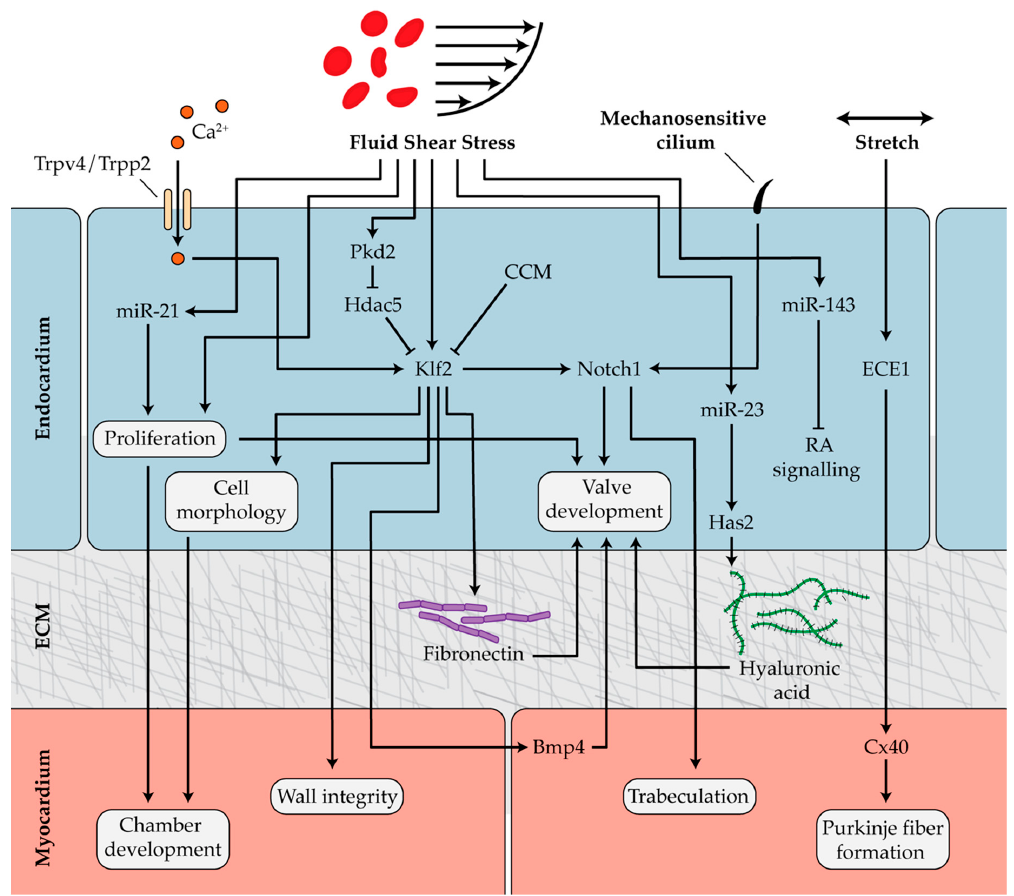
Figure 3. Mechanosensitive pathways involved in heart development. During chamber morphogenesis, hemodynamic forces control endocardial cell proliferation and, through Klf2a, direct endocardial cell morphology. Blood flow also has an impact on myocardial wall integrity, an effect that is mediated by klf2 expression in the endocardium. Cilia sense fluid forces and activate Notch1 signaling to regulate trabeculation. During valve development, Klf2a responds to blood flow to activate Bmp4 in the myocardium and fibronectin synthesis in the extracellular matrix (ECM). Klf2a is positively regulated by mechanosensitive ion channels Trpv4 and Trpp2 and suppressed by cerebral cavernous malformation (CCM) proteins and the chromatin modifier Hdac5. Stretch induces endocardial endothelin converting enzyme 1 (ECE1) and myocardial Cx40 expression, which controls Purkinje fiber differentiation. Flow-responsive miR-21 regulates proliferation in the developing valves. Hyaluronan synthase 2 (Has2) produces hyaluronic acid, an important component of the ECM. Shear stress-responsive miR-23 regulates Has2 and is critical for valve formation. miR-143 inhibits retinoic acid (RA) signaling in a spatially-controlled manner during cardiogenesis. 4.3. Mechanotransduction During Formation of the Outflow Tract, Conduction System, and Epicardium